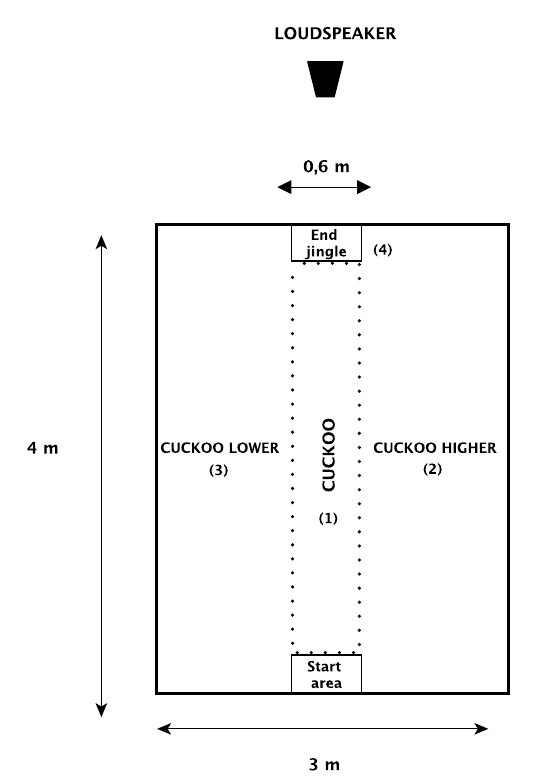
Figure 1. The area of the Following the Cuckoo Sound responsive floor with the 4 sound